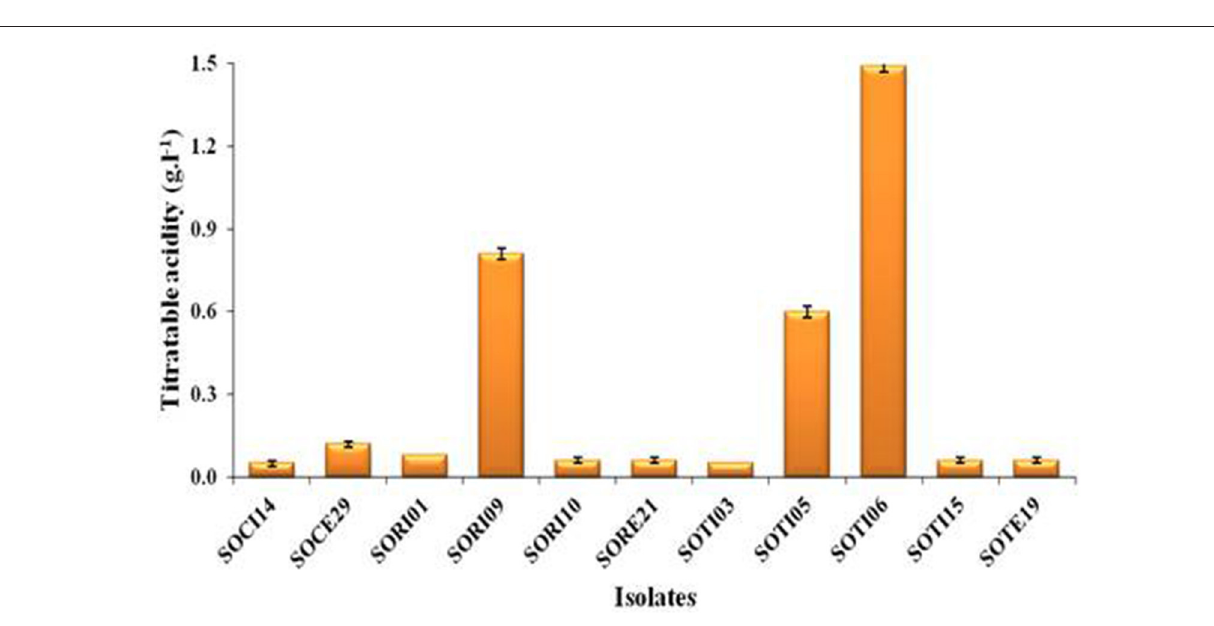
FIGURE 3 | Titratable acidity of selected CDB isolates. The TA was determined from the culture supernatant of the isolates and the content was higher when these isolates produce acids. Means of three replicate values plotted and error bars indicate the standard